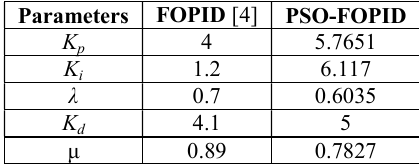
Table 5. Simulation height position characteristics of all controllers for Case I